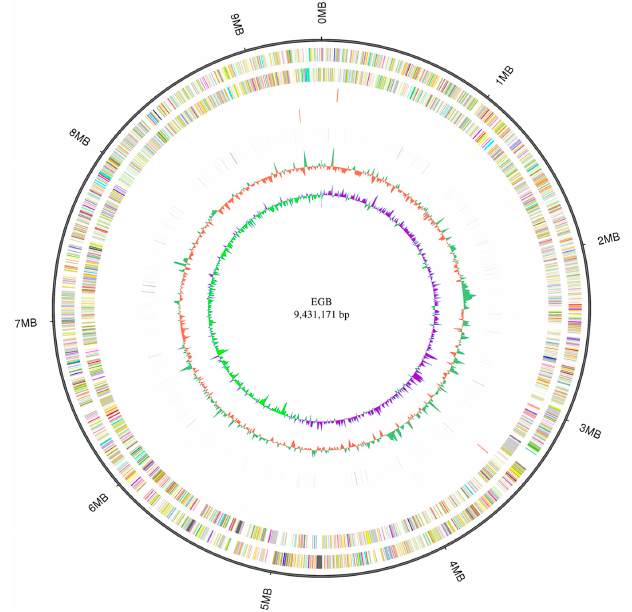
Figure 1. Circular representation of the complete genome of Corallococcus sp. strain EGB. The outermost circle is the coordinate of the genome position. From the outside to the inside, the first circle represents COG annotation gene distribution of the forwarding strand, colored according to cluster; the second circle illustrates COG annotation of the reverse strand; the third circle depicts the ncRNA distribution of the forwarding strand; the fourth circle represents the ncRNA distribution of the reverse strand; the fifth circle illustrates the repeat; the sixth circle depicts the GC content; the seventh circle denotes the GC skew.